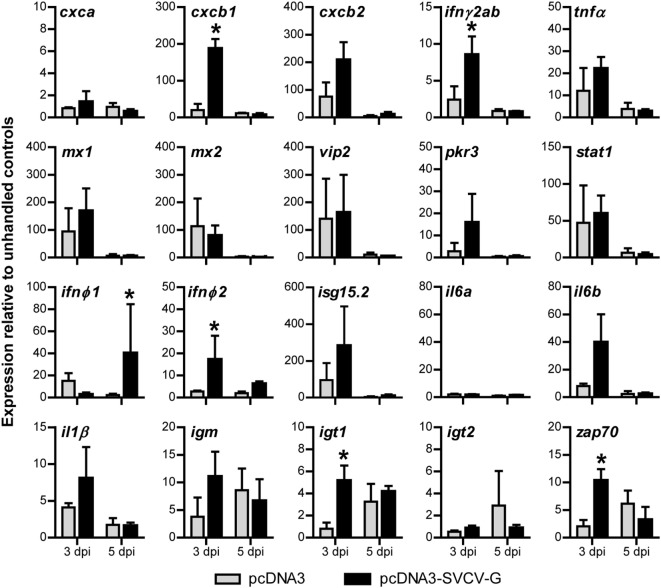
Gene expression analysis of the local immune response after i.m. DNA vaccination against spring viremia of carp virus (SVCV). Carp were injected with 0.1 µg/g of either pcDNA3 or pcDNA3-SVCV-G. Muscle tissue at the site of injection was excised at 3 and 5 days postinjection (dpi). Expression of the indicated immune-relevant genes was normalized against the housekeeping gene s11 of the ribosomal subunit 40S and expressed relative to the unhandled control at time point 0 h. Asterisks (*) indicate significant differences (p < 0.05) between the pcDNA3 and pcDNA3-SVCV-G group at the respective time point as assessed by one-way ANOVA, followed by a Tukey post hoc test. Bars indicate average and SD of n = 3 fish per time point.